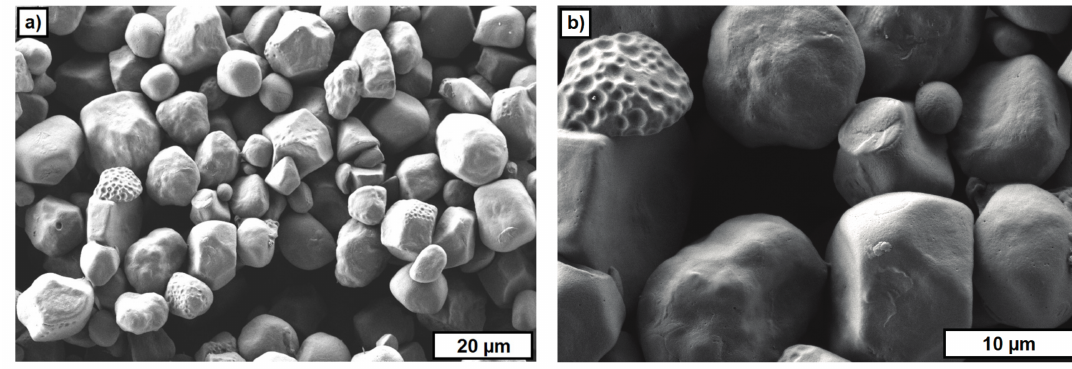
Figure 11. FESEM images of polysaccharide powder. ( a ) Overview; ( b ) detail.